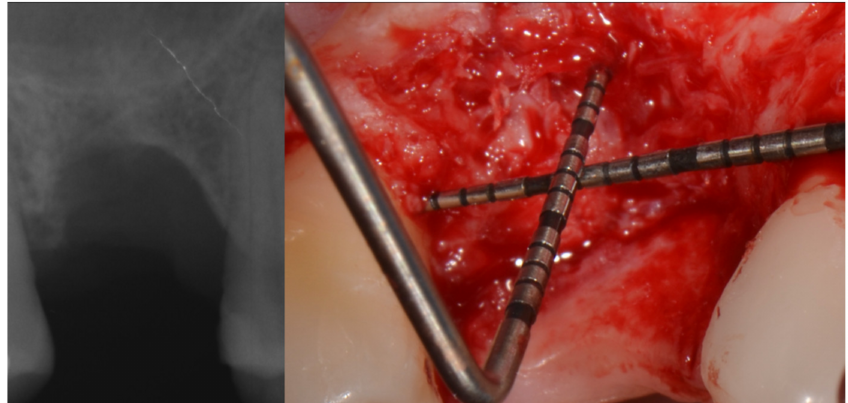
Figure 6. Rx of the healed defect and its measurement.